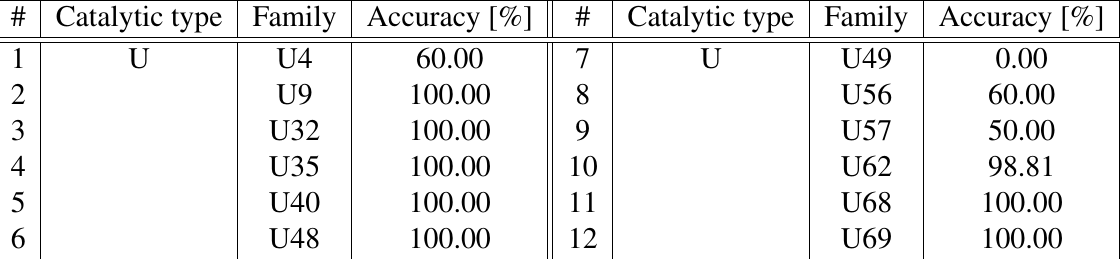
Table 13: Accuracy values for the SVM system and